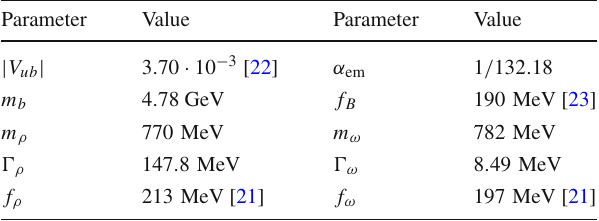
Table 1 Input parameters from PDG [24] unless stated otherwise. The value of f B is taken from FLAG [23] using inputs from [25–28]. Here wequotetheexclusive | V ub | valuefromHFLAV[22],whichuseslattice ( 5 ) ( 5 GeV inputs from [29,30]. Here α em = α em